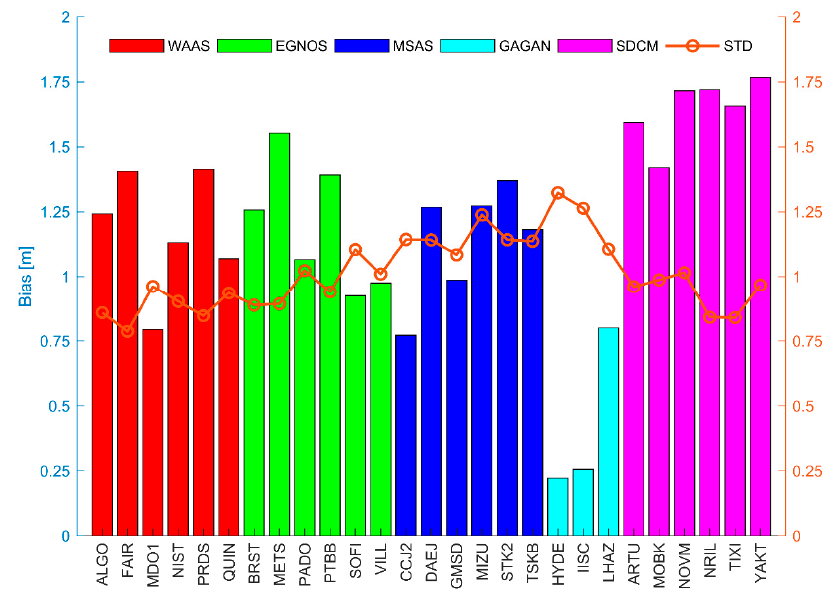
Figure 16. The bias and STD values of GPS broadcast ionospheric correction errors for each selected IGS station.